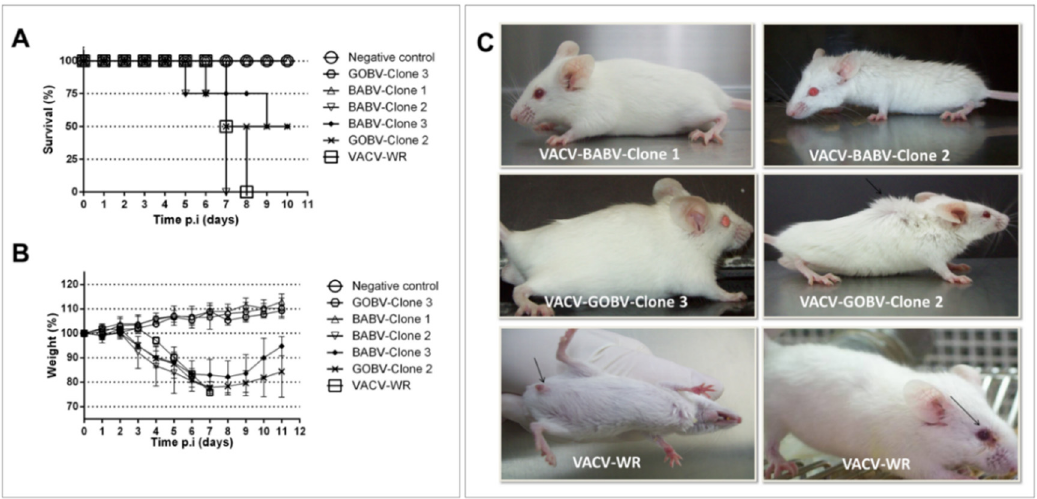
Figure 4. Virulence assays in a BALB/c mice model. Groups of four-week-old mice ( n = 4) were inoculated by intranasal route with 106 PFU/10 µL of VACV-BABV strain clones 2 and 3 (large-plaque) and clone 1 (small plaque), and VACV-GOBV clone 2 (large plaque) and clone 3 (small plaque). VACV-WR was used as virulent control, and the negative control group was inoculated with PBS. No mice infected with small plaque clones died while the mice infected with large plaque clones had survival rates of 0% and 50%, showing variations in survival rates between the clones ( A ); Uninfected mice (negative control) and animals infected with small plaque clones gained weight, while mice infected with large plaque clones lost weight similarly to mice infected with virulent control VACV-WR ( B ). Ruffling fur and arching back were observed in mice infected with large plaque clones on day 4